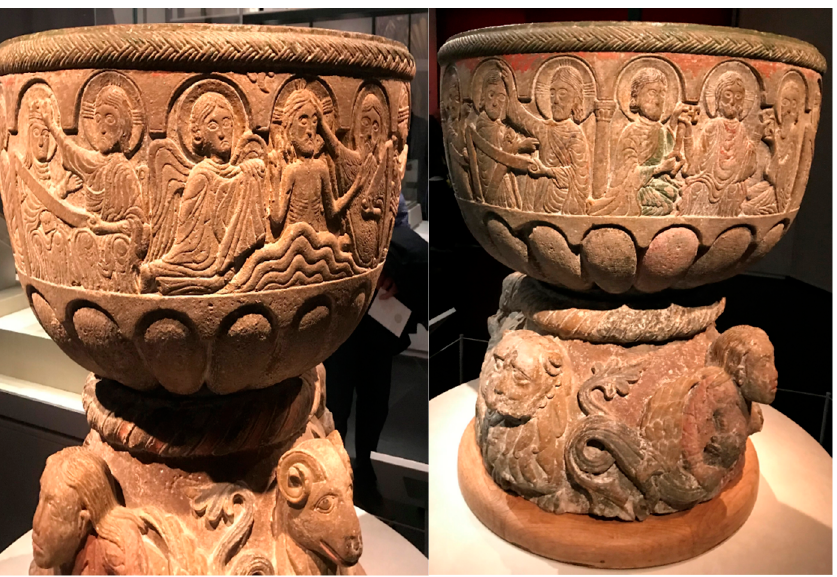
Figure 2. Baptismal font from Lyngsjö Church, Sweden. Detail of the Coronation of the Virgin and Baptism of Christ. © the Author.